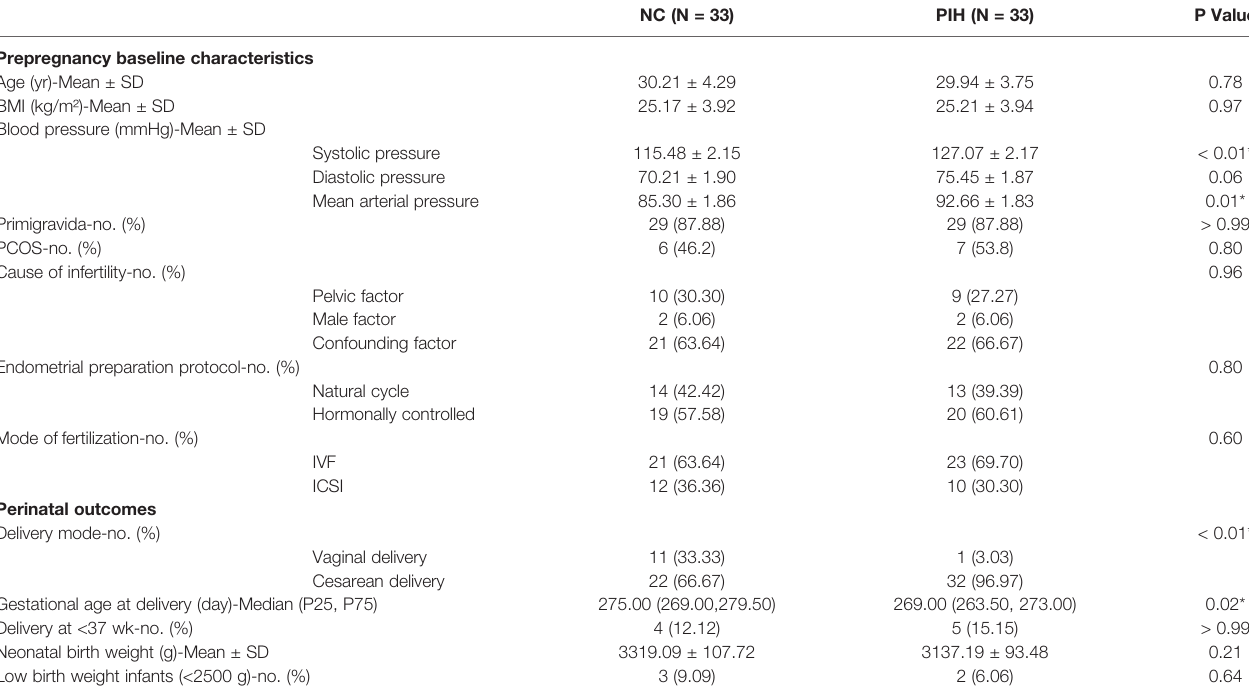
TABLE 1 | Baseline characteristics and perinatal outcomes of the participants.